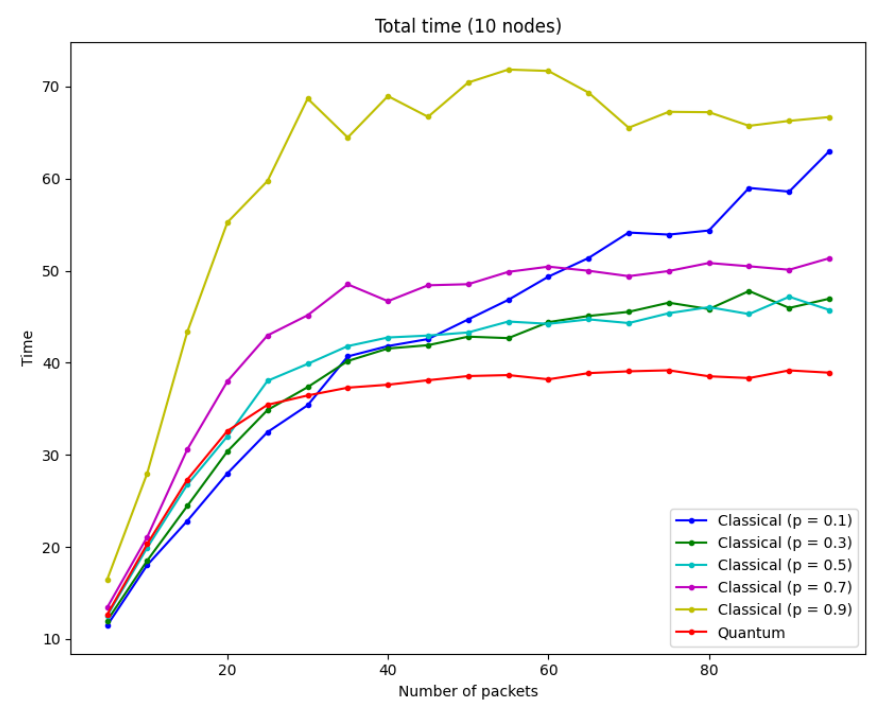
Figure 8. Total time = routing time + traveling time, it is evident that the minimum total time correspond to the quantum case when the number of packets